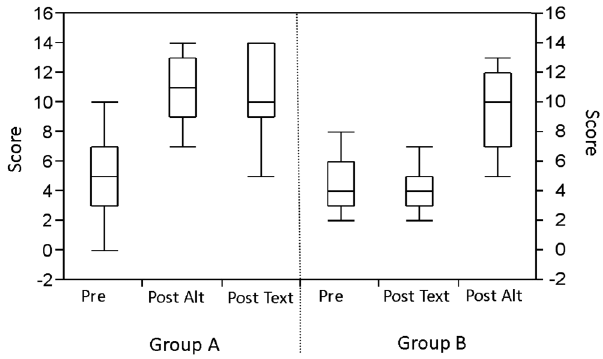
FIG. 4. Boxplots of score distributions: Presurvey, Post Alt, and Post Text for groups A and